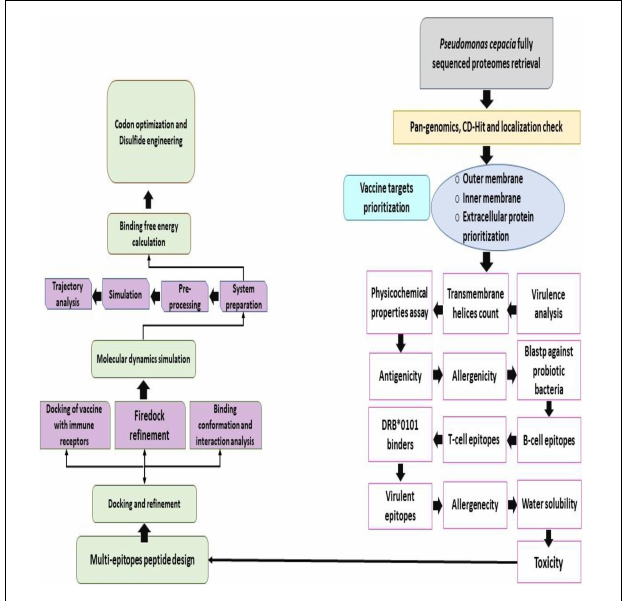
FIGURE 1 | Work flow of the steps done in the study to design a multi-epitopes vaccine against B. cepacian .